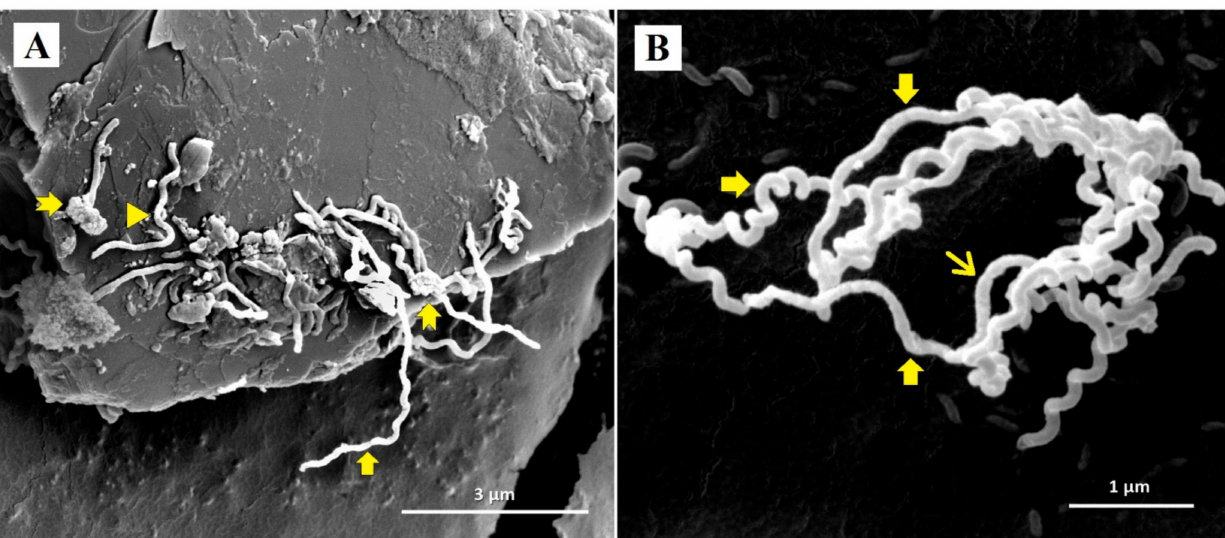
Figure 5. SEM micrographs of L. interrogans serovar Australis treated with the MIC of doxycycline combined with the MIC of AE at 30,000 × ( A ) and 60,000 × ( B ) magnifications. Block arrows: distorted and less coiling; arrow: thinning; arrowhead: shortened; notched arrows: irregular and blebbing